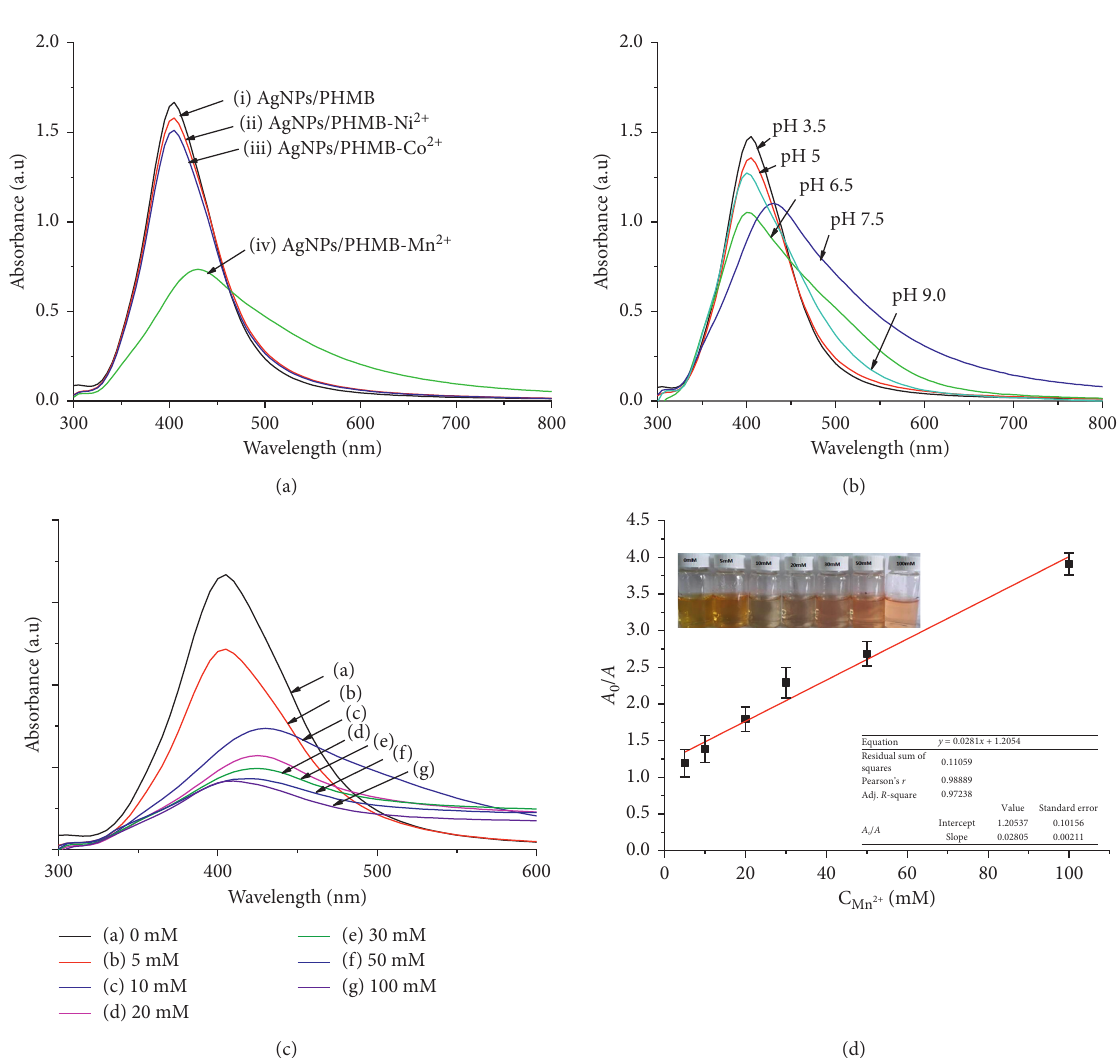
Figure 8: Colorimetric detection of Mn 2+ ions using the colloidal Ag-NPs: (a) UV-Vis spectra of AgNPs/PHMB without and with adding Co 2+ , Ni 2+ , and Mn 2+ solution; (b) the UV-Vis spectra of AgNPs/PHMB solutions with different pH ranging from pH 3.5 to pH 9.0 after adding 10mM Mn 2+ solution; (c) UV-Vis spectra of AgNPs/PHMB in the presence of Mn 2+ with different concentrations from 0 to 100mM; and (d) a calibration curve for Mn 2+